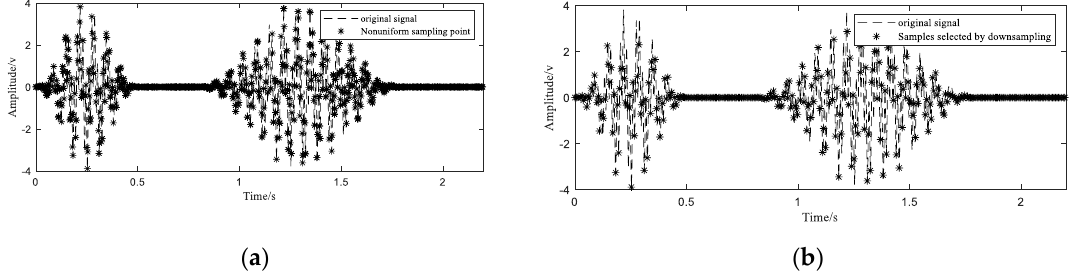
Figure 6. Reorganization of sampling points ( a ) and screening of sampling points ( b ).